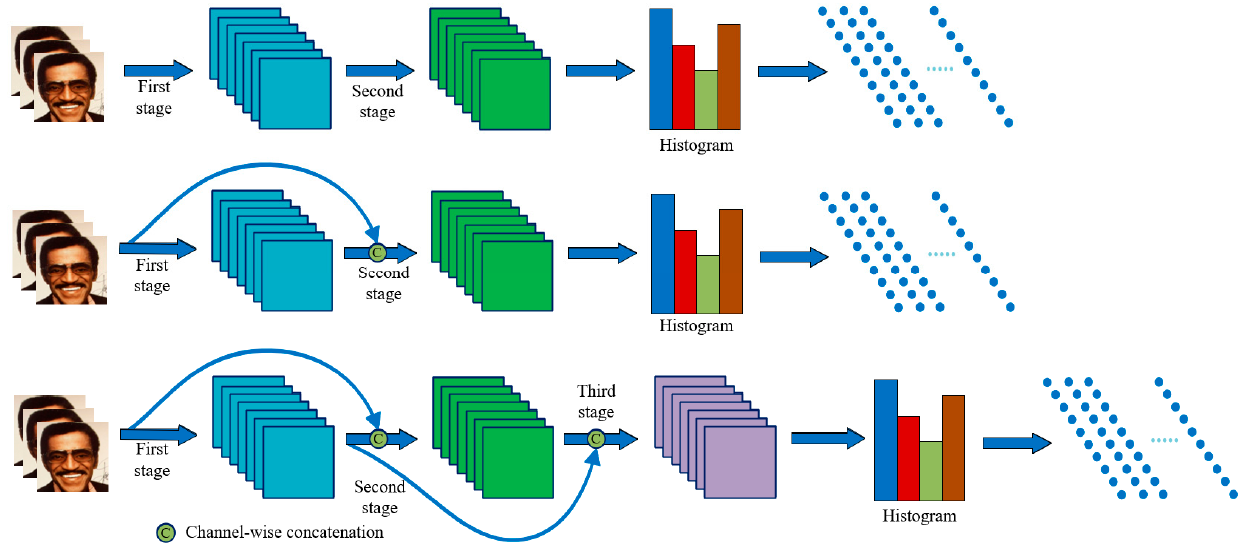
Figure 1. Illustration of the architecture of the PCANet, MPCANet, and MPCANet3 models. The first row represents PCANet, the second row represents MPCANet, and the third row represents MPCANet3.